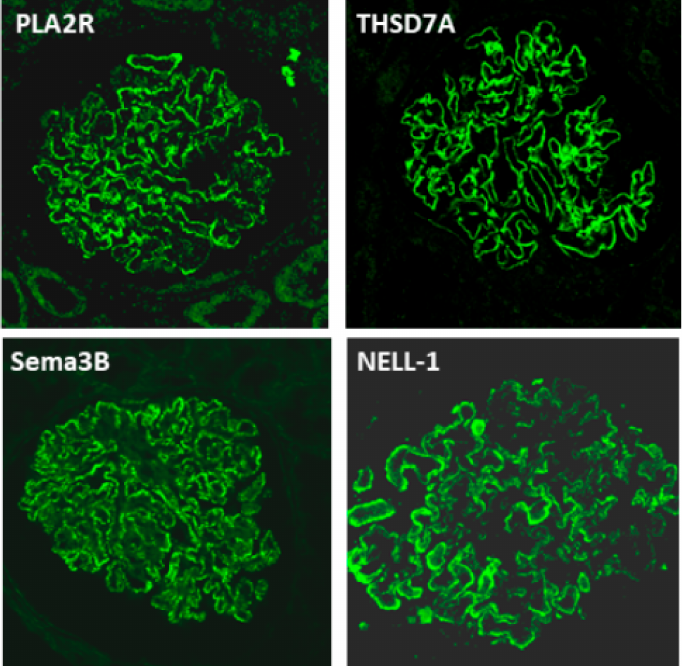
Figure 5. Immunofluorescence staining of the four antigens: PLA2R, THSD7A, Sema3B, NELL-1. Paraffin embedded tissue biopsies were stained after retrieval with the relevant antibodies. Fine granular staining of the immune deposits is seen on the outer aspect of the glomerular basement membrane. Note that some capillary loops are not, or weakly stained with anti-NELL-1